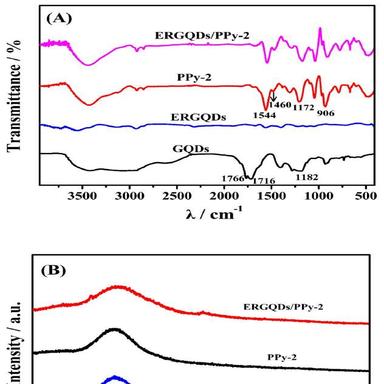
(A) FT-IR spectra of GQDs, ERGQDs, PPy-2 and ERGQDs/PPy-2. (B) XRD patterns of ERGQDs, PPy-2 and ERGQDs/PPy-2.